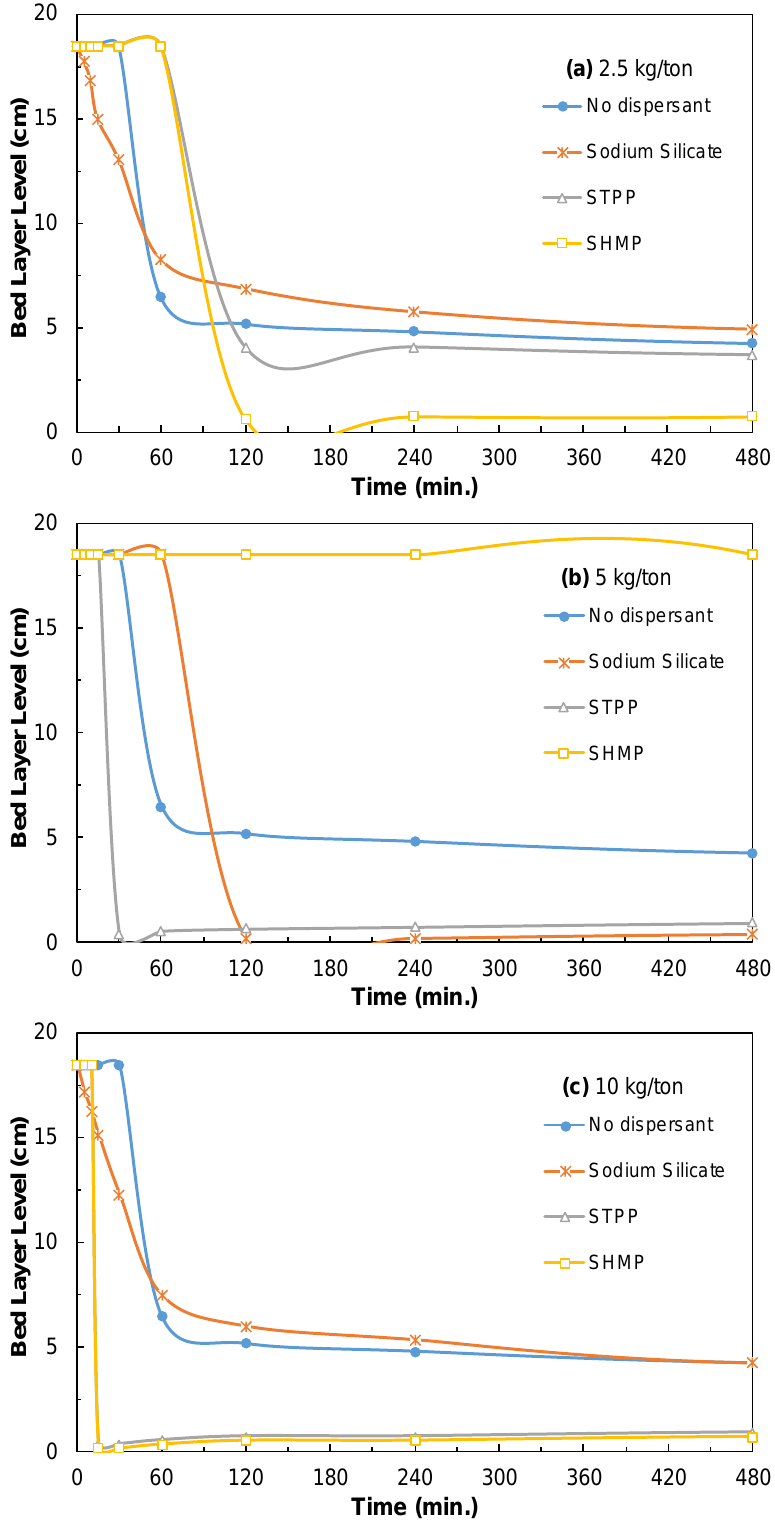
Figure 10. Kaolinite sedimentation behavior in the presence of dispersants at concentrations of ( a ) 2.5 kg/ton, ( b ) 5 kg/ton, and ( c ) 10 kg/ton at natural pH and room temperature.